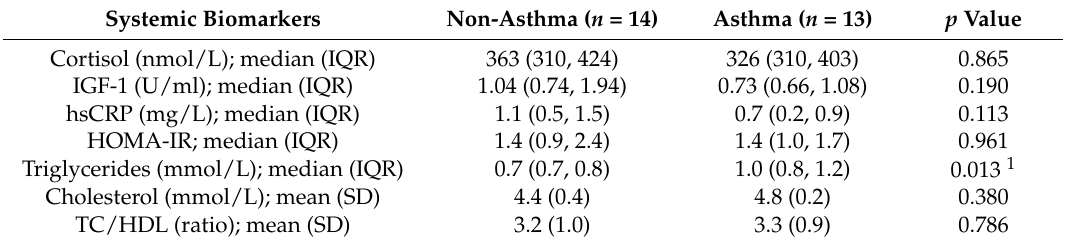
Table 3. Metabolic biomarkers in children with and without asthma, referred for an overnight polysomnography.